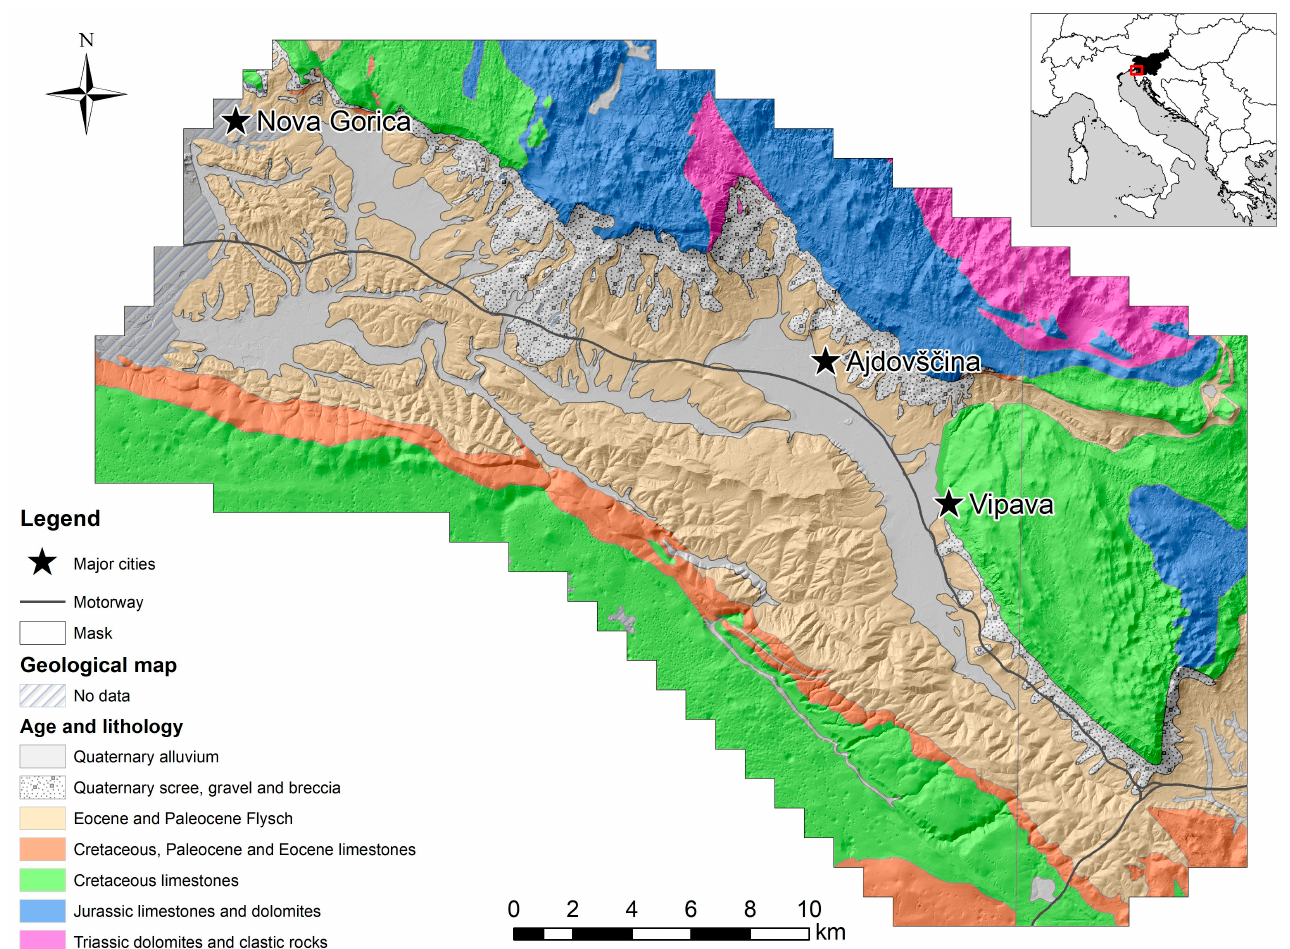
Figure 1. Simplified geological map of the Vipava Valley. Basic geologic map in scale 1:100,000 [51,56].